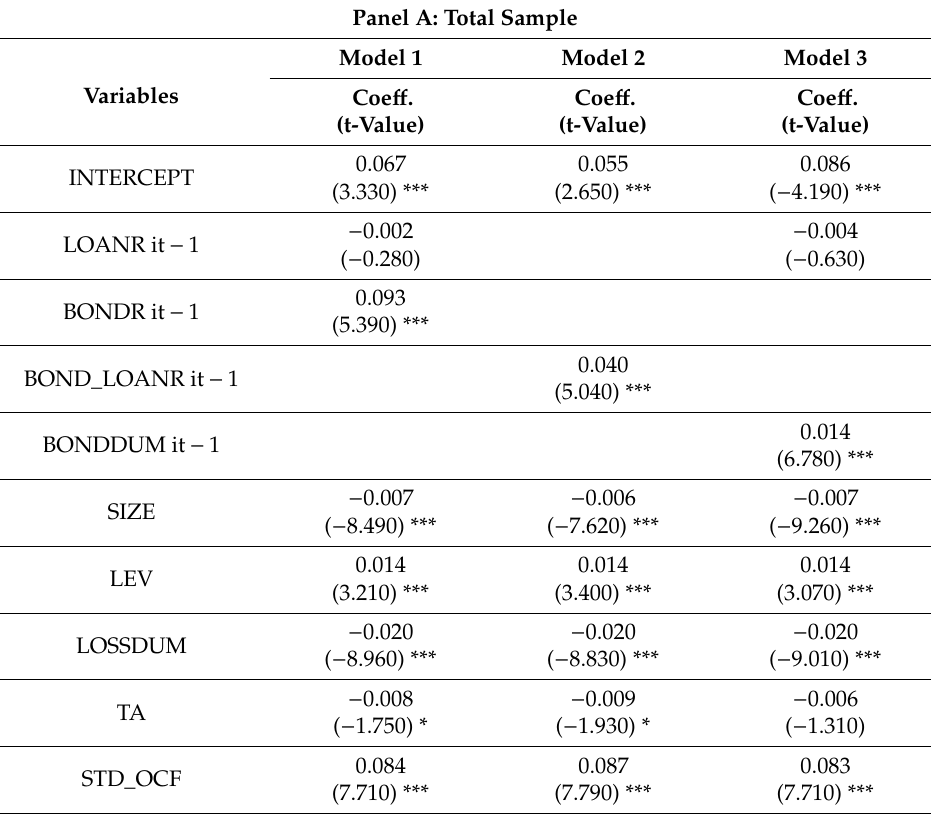
Table 9. Debt origin and investment e ffi ciency: analysis result for time di ff erence